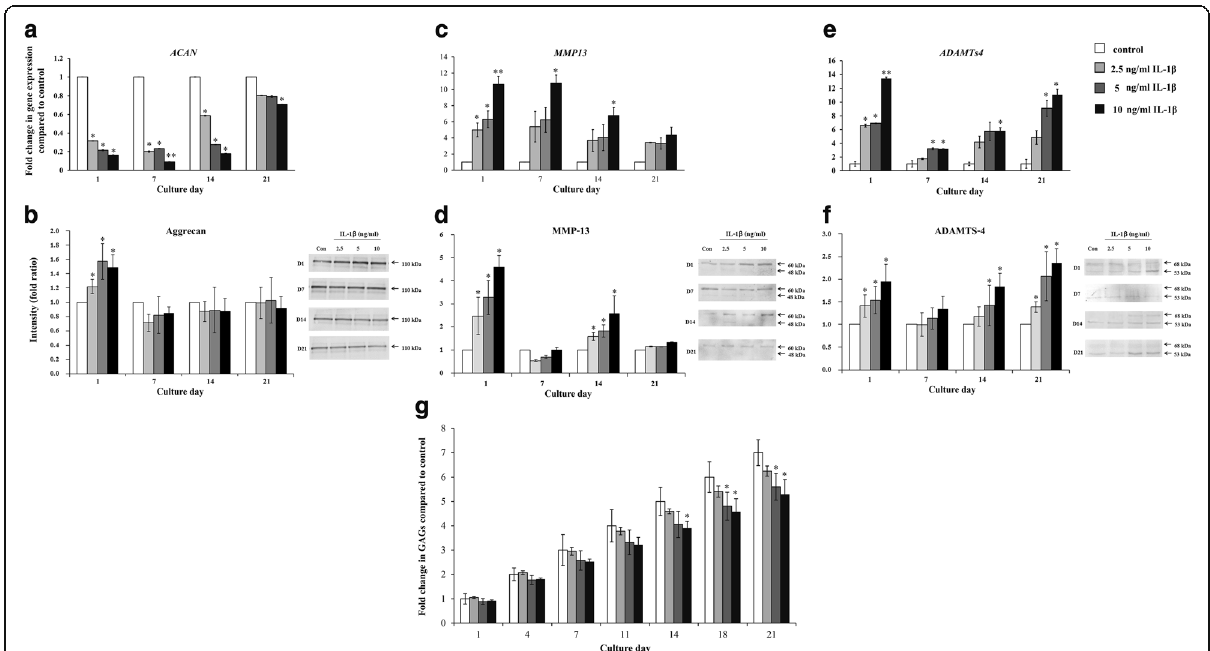
Fig. 1 Effects of various IL-1 β concentrations (2.5 to 10 ng/ml) pre-treatment on the gene and protein expression level of aggrecan ( a , b ), MMP- 13 ( c , d ) and ADAMTS-4 ( e , f ) of HAC pellets. GAGs released in media during 21 days of culture with various concentrations of IL-1 β (0 to 10 ng/ ml) in 3-day pre-treated HAC pellets ( g ). The data presented are the mean ± S.D. of 3 independent cultures. Statistical significance compared to the untreated (control) * = p < 0.05, ** = p <